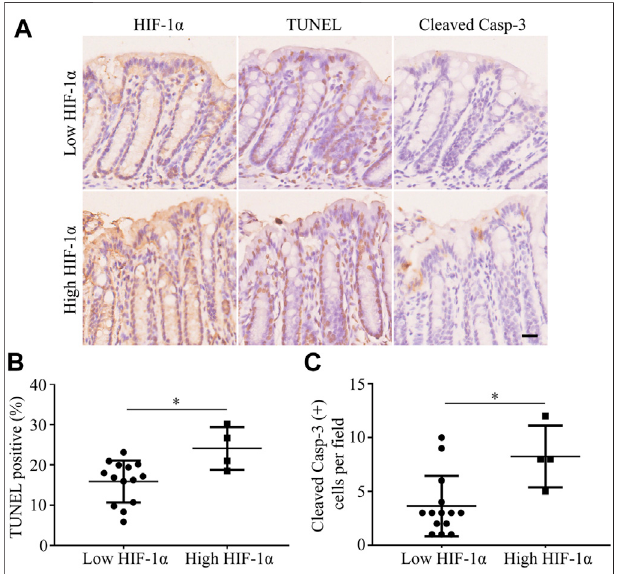
FIGURE 1 | Apoptosis is increased adjacent to high-HIF-1 α area in rectum of mouse after 25 Gy radiation. (A) Representative pictures of TUNEL and cleaved casp-3 staining in low-HIF-1 α and high-HIF-1 α groups in vivo . Scalebar:20 μ m. (B) TheextentofTUNELand (C) thecountsofcleaved casp-3 positive cells per fi eld were positively correlated with the degree of hypoxia. * p <